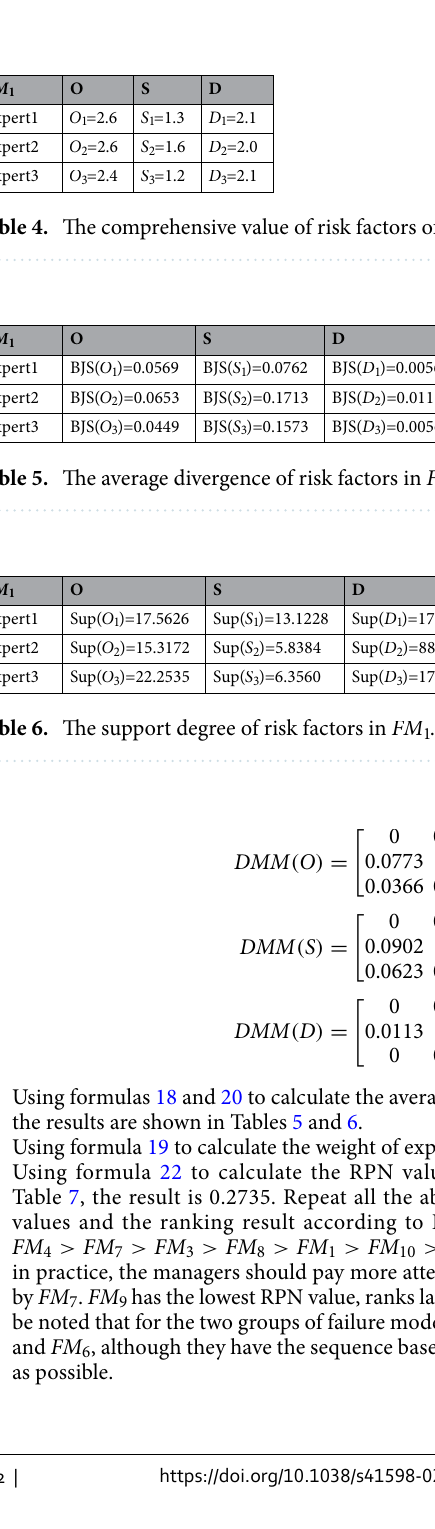
Table 3. The belief structure of the first failure mode.